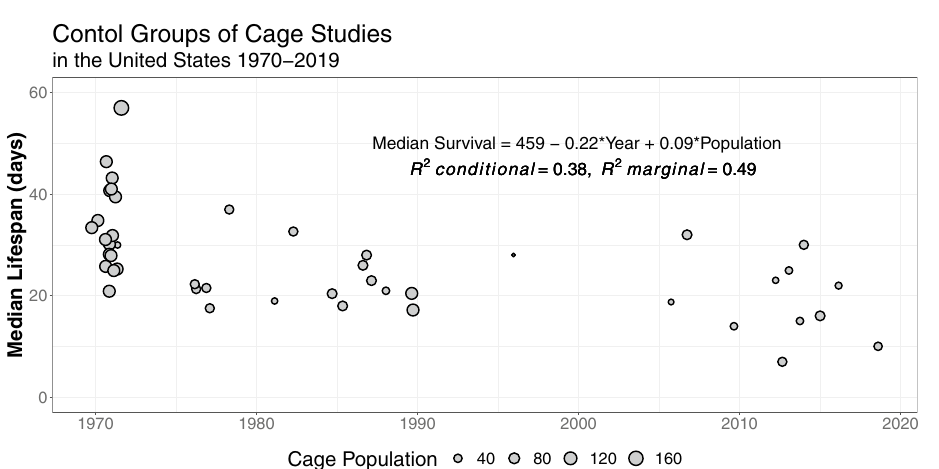
Figure 3. Median lifespans for the control groups of cage studies performed in the US between 1970 and 2019. Significant differences in median lifespans were negatively correlated with time and positively correlated with cage populations. Point size represents cage population. Equation represents the mixed modeling